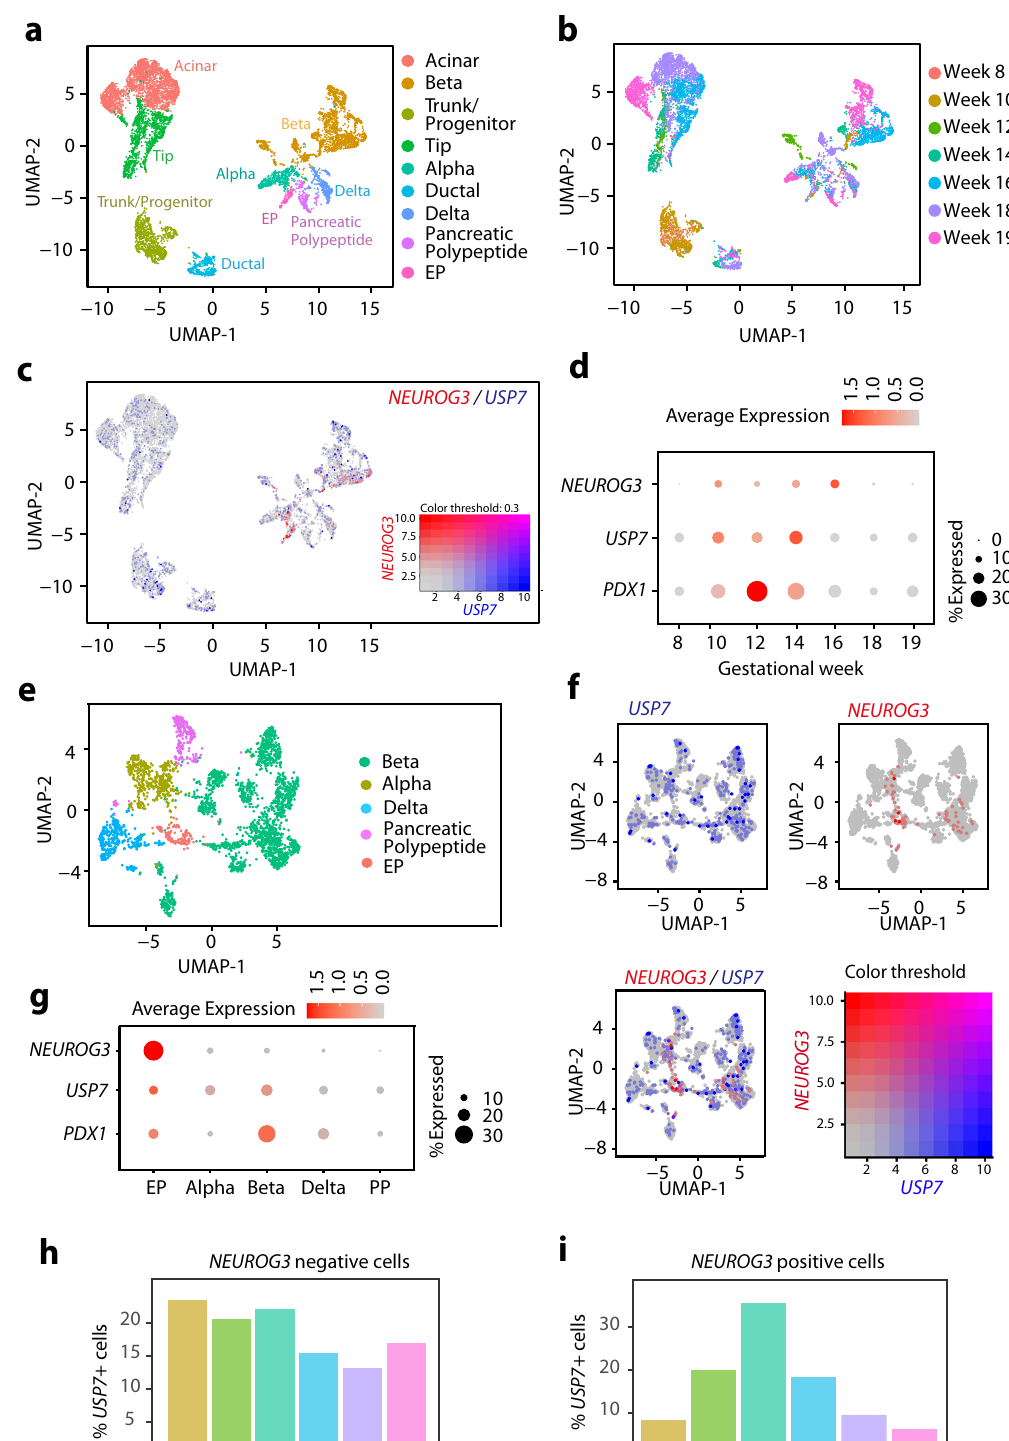
Fig. 5 | USP7 expression during human embryonic pancreas development. a UMAP projection of pancreatic epithelial cells in OMIX236 human fetal pancreas dataset. Cells are colored by assigned clusters. b UMAP projection of pancreatic epithelial cells. Cells are colored by developmental timepoints. c Co-expression of NEUROG3 (red) and USP7 (blue) across the scRNA-seq dataset. d Expression of NEUROG3 , USP7 , and PDX1 across developmental timepoints in NEUROG3 -expres- sing clusters (EP, alpha, beta, delta, and pancreatic polypeptide) in the OMIX236 34 scRNA-seq dataset. e UMAP projection of endocrine cells in OMIX236 human fetal